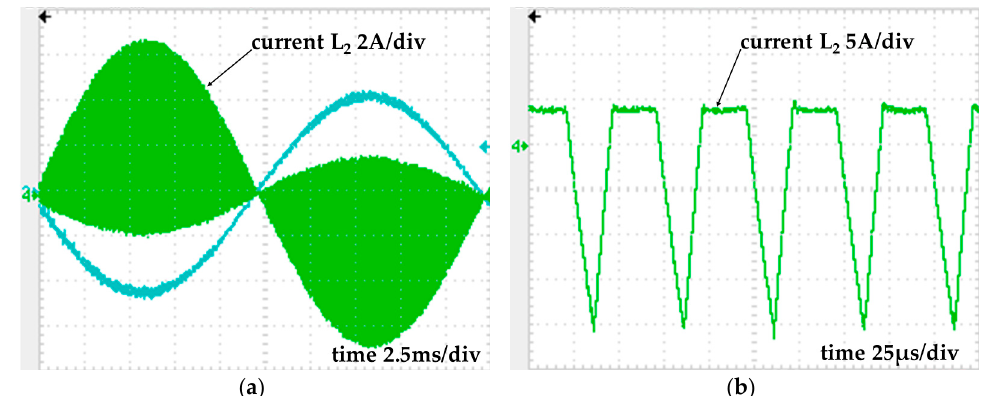
Figure 12. Operational point of f = 40 Hz: ( a ) L 2 current (2 A/div), L 2 current (5 A/div) and ( b ) L 2 current (5